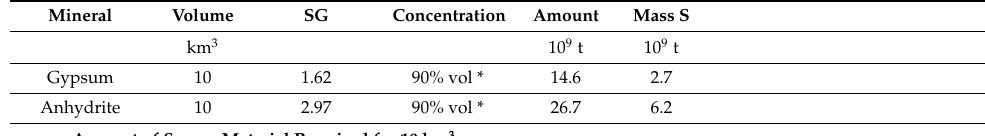
Table 2. Mass Balance of